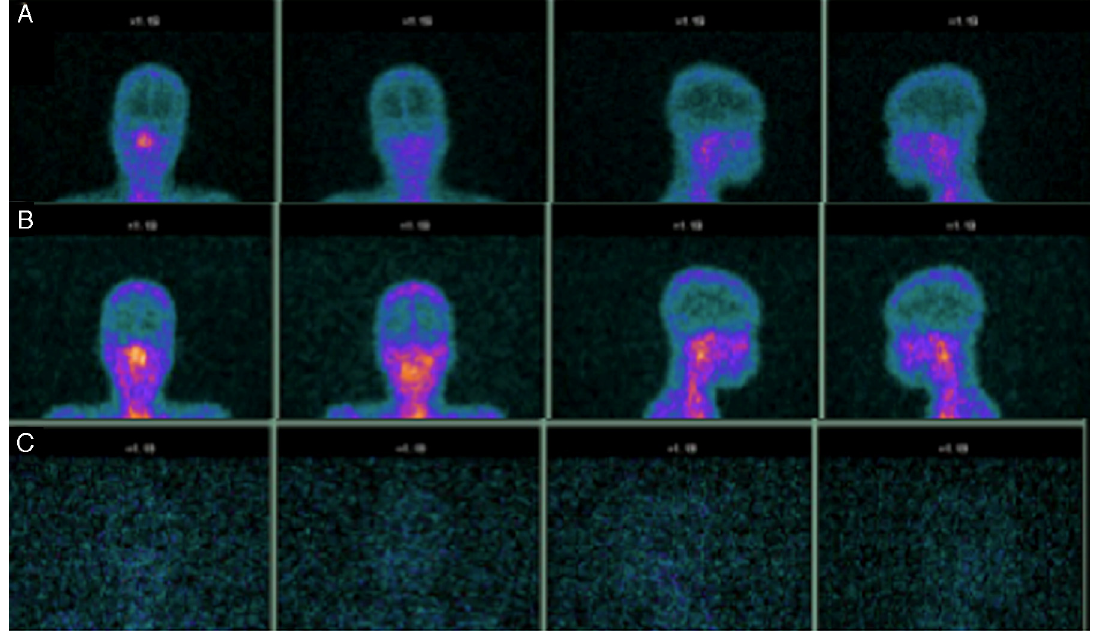
Figure 2 99m Tc-mononuclear leukocyte scintigraphy (A---C). Planar scintigraphs from one, three, and 24 h after labeled